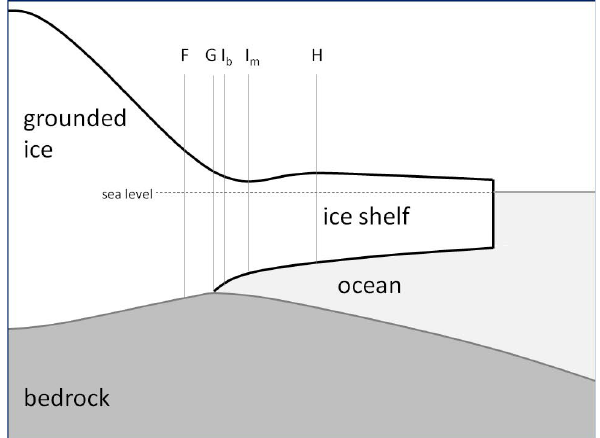
Fig. 1. Schematic of cross-section through the margin of the Antarc- tic ice sheet. F refers to the most seaward point not vertically dis- placed by tidal flexure; G is the point where the ice loses contact with the bed (at low tide); I b and I m represent inflection points of the surface slope; and H is the most landward point that experiences full tidal flexure (adapted from Fricker et al., 2009). The ASAID grounded ice boundary is most consistent with point I b .